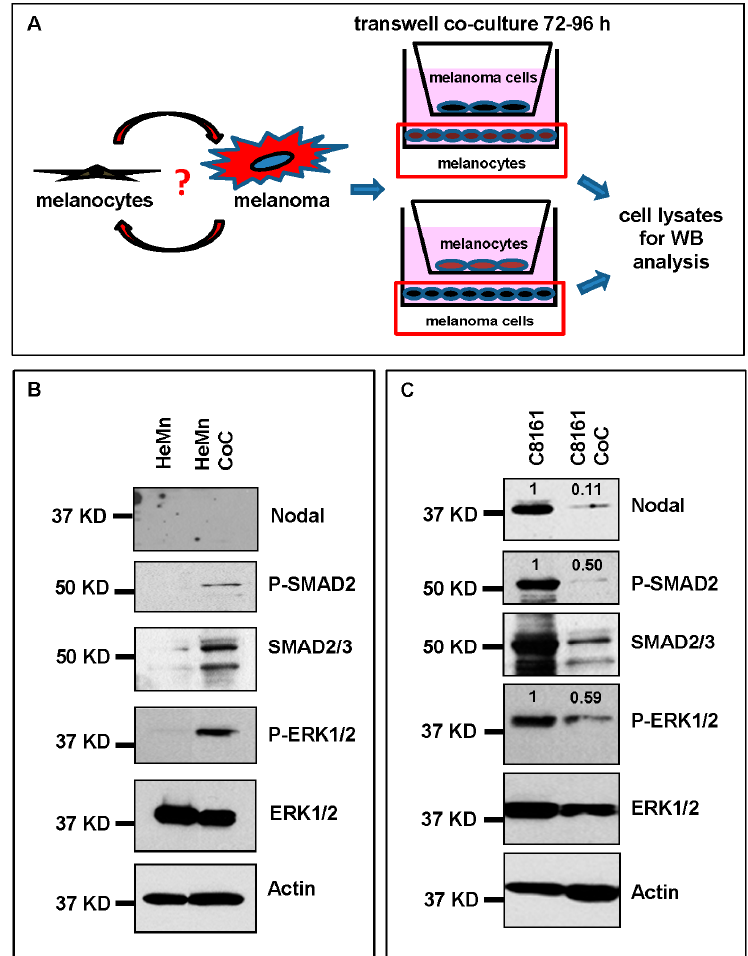
Figure 3. Co-culture (CoC) experiments. ( A ) Schematic diagram summarizing the co-culture experiments using HeMn melanocytes and C8161 melanoma cells. Lysates of cells growing on the bottom well (red square) were used for Western blotting; ( B ) Western blot results show increased expression of P-SMAD2 and P-ERK1/2 in HeMn melanocytes co-cultured with human C8161 melanoma cells compared to control HeMn cells culured alone. However, Nodal expression was not detected in HeMn cells grown alone or in co-culture with C8161 melanoma cells; and ( C ) Results from WB analysis show reduced levels of Nodal, P-SMAD2 and P-ERK1/2 in C8161 melanoma cells when co-cultured with HeMn melanocytes. Numbers above WB bands represent densitometric units, normalized to actin loading control, total SMAD2/3 or total ERK1/2, as appropriate, relative to control.